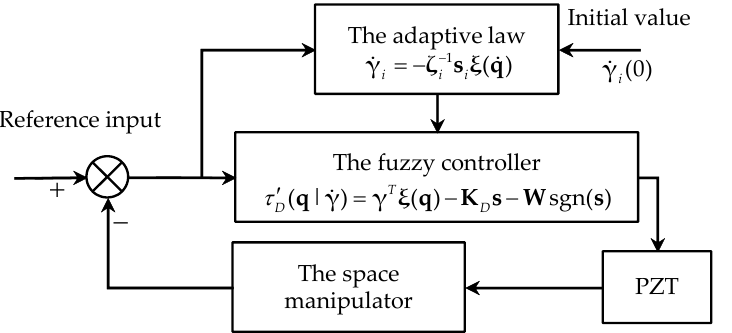
Figure 10. Schematic of adaptive fuzzy controller.